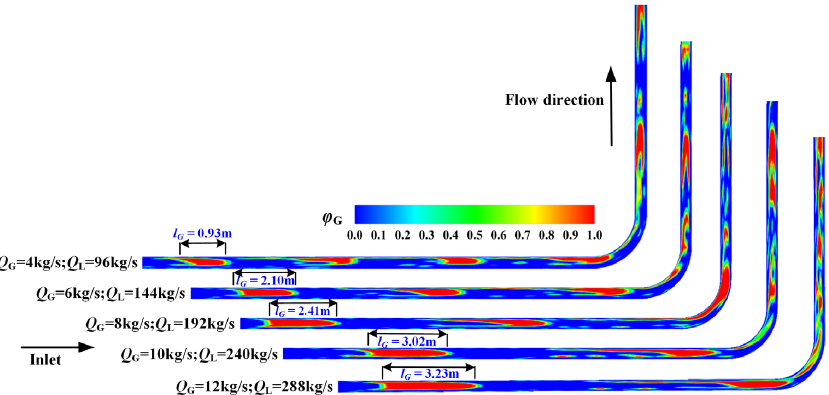
Figure 16. Comparison of the gas plug length produced in the upstream horizontal tube and the flow evolution in the first bend (Bend 1) at different inlet mass flow rates.